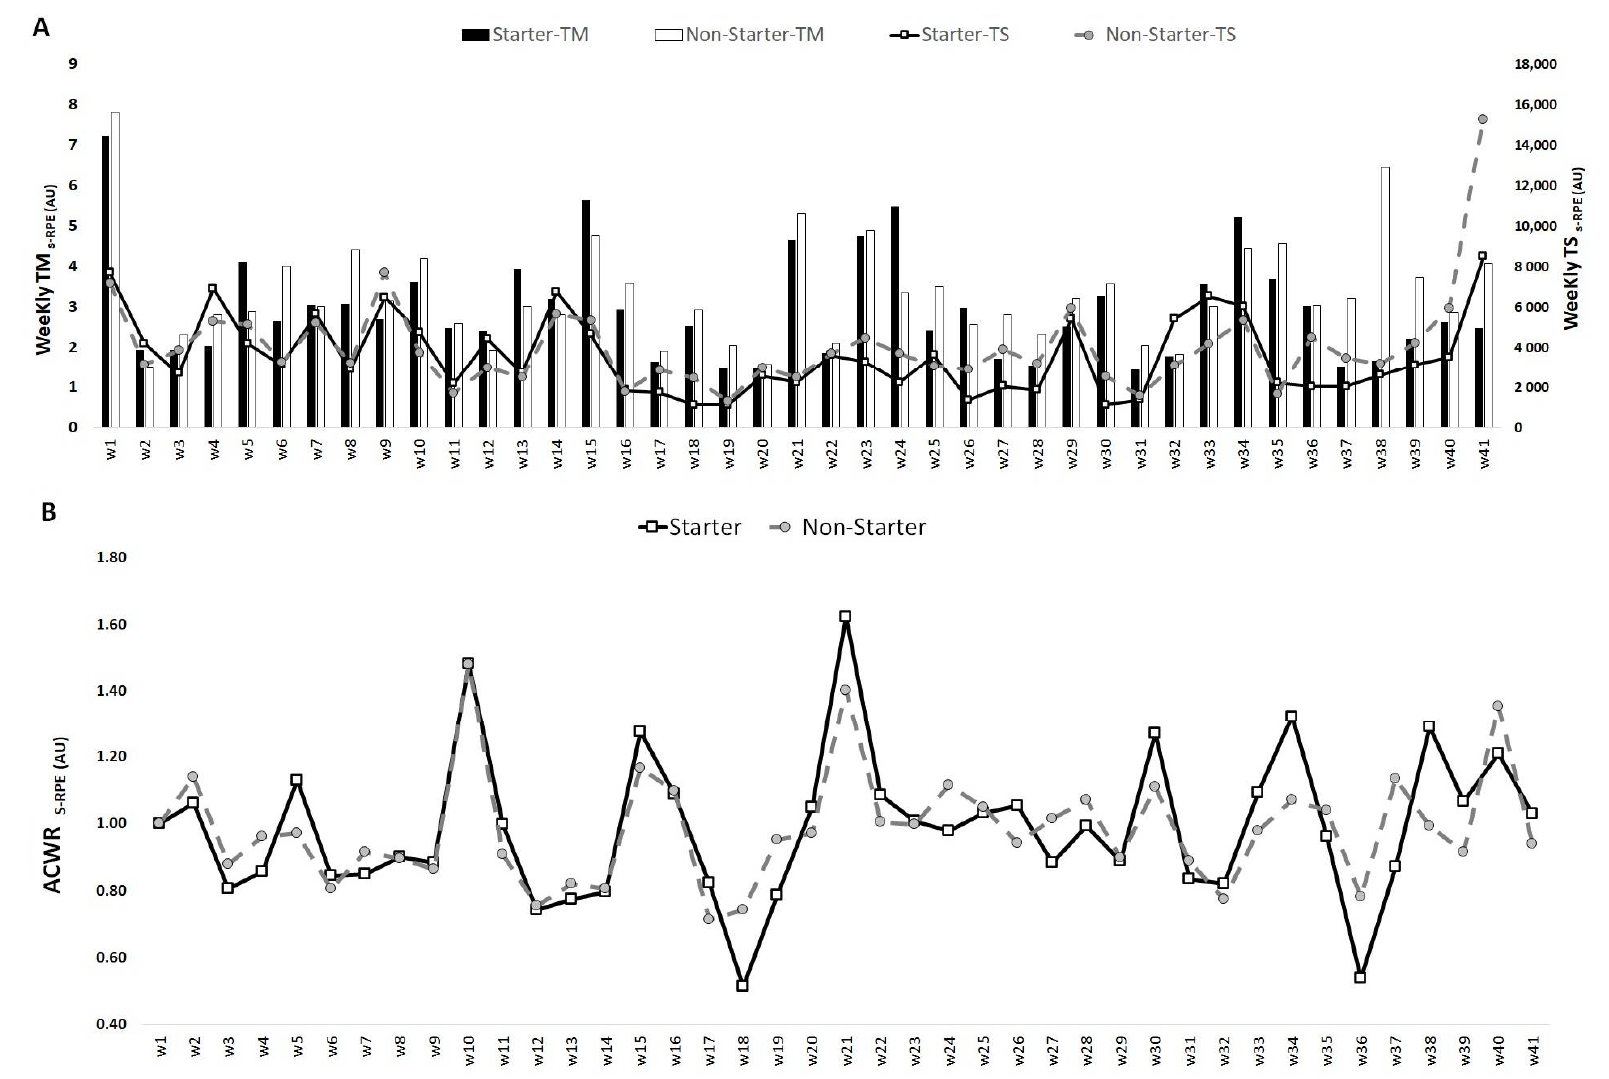
Figure 1. TM, TS ( A ) and ACWR ( B ) variations calculated through the s-RPE across 41 weeks for starters and non-starters.